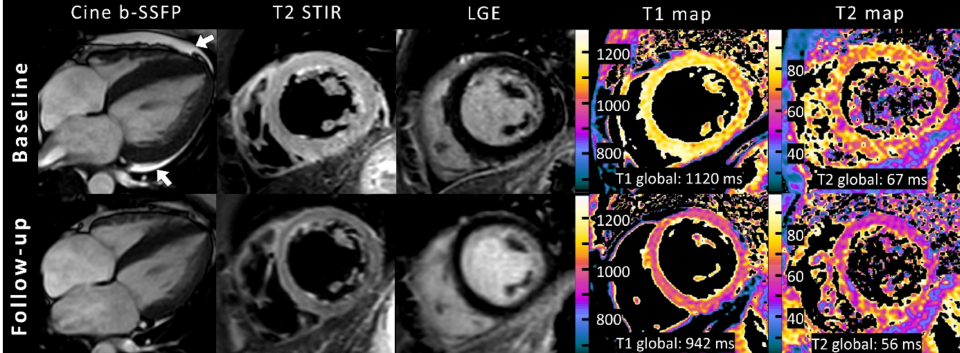
Figure 3. Representative example of cardiac magnetic resonance in a 32-year-old female with acute peripartum cardiomyopathy and recovery at follow-up after 2 months. Cine images (balanced steady-state free precession, b-SSFP) are oriented in horizontal long-axis view and at end systole and showed highly reduced left ventricular ejection fraction (35%) with global hypokinesia, left ventricular dilatation (left ventricular end-diastolic volume index: 118 mL/m 2 ), and pericardial effusion (white arrows). Baseline fat-suppressed images (T2-weighted short TI inversion recovery, T2-STIR) at end diastole revealed extensive diffuse myocardial edema, which normalized at follow-up. No focal enhancement was identified on initial or follow-up late gadolinium enhancement (LGE) imaging. Quantitative mapping showed high global myocardial native T1 and T2 relaxation times at baseline MRI and normalization at